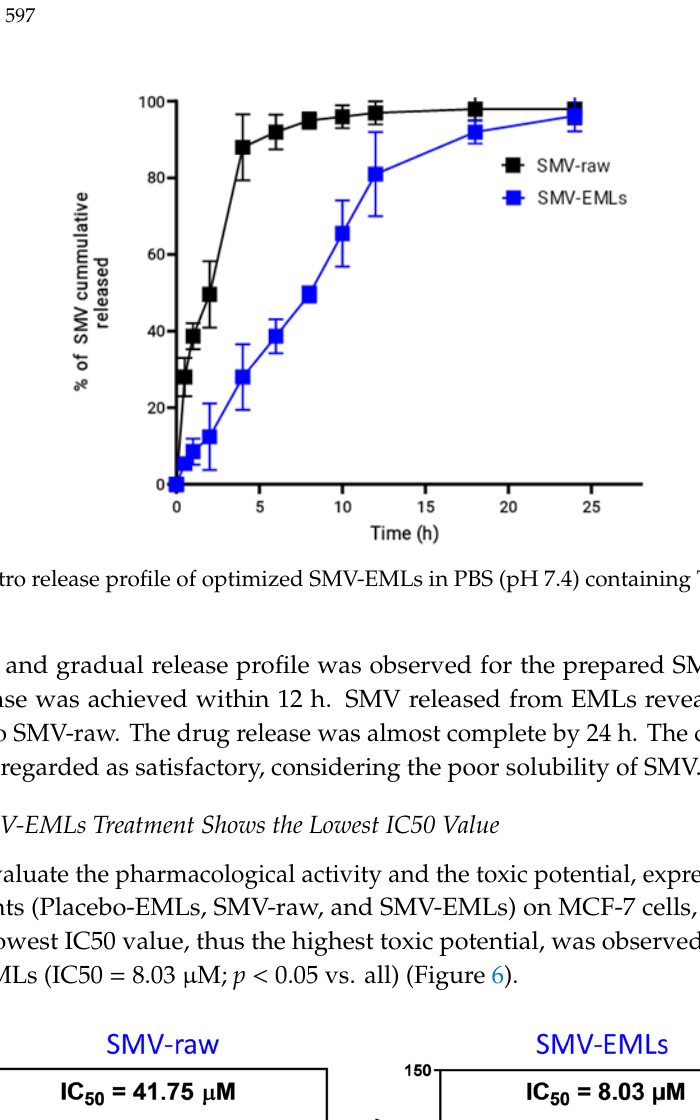
Figure 4. TEM of optimized SMV-EMLs (80,000× magnification).